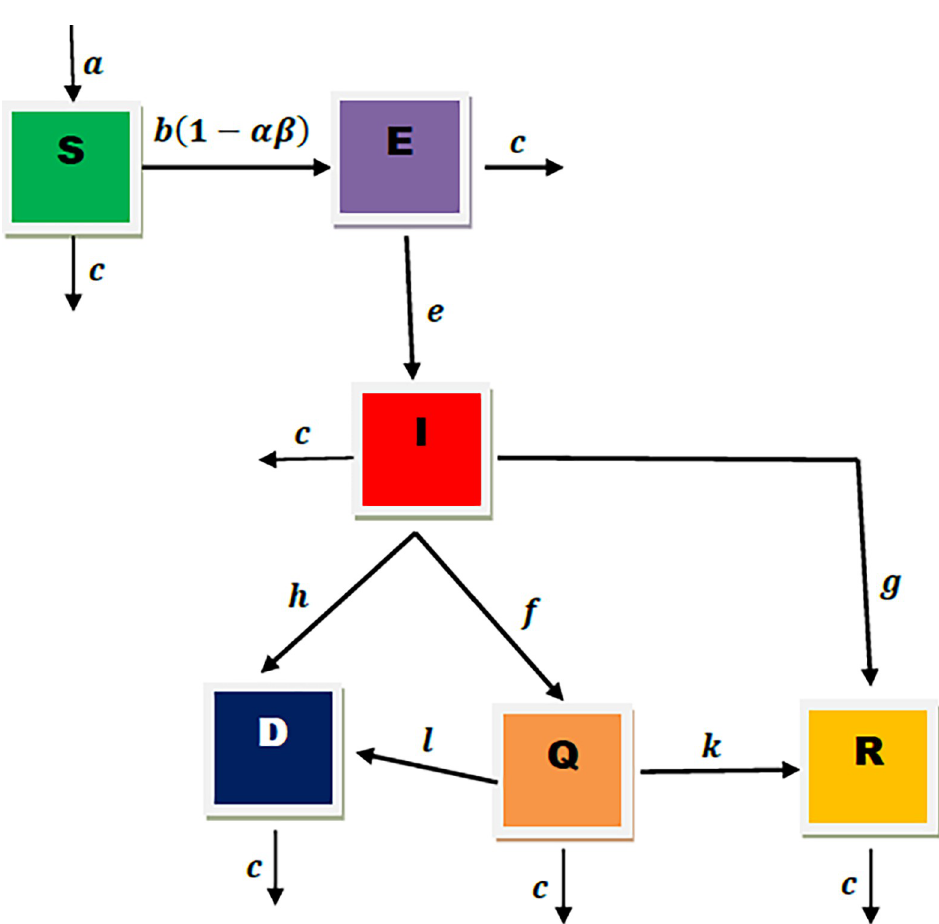
Fig 1. Depicts a flow chart of the proposed SEIQRD